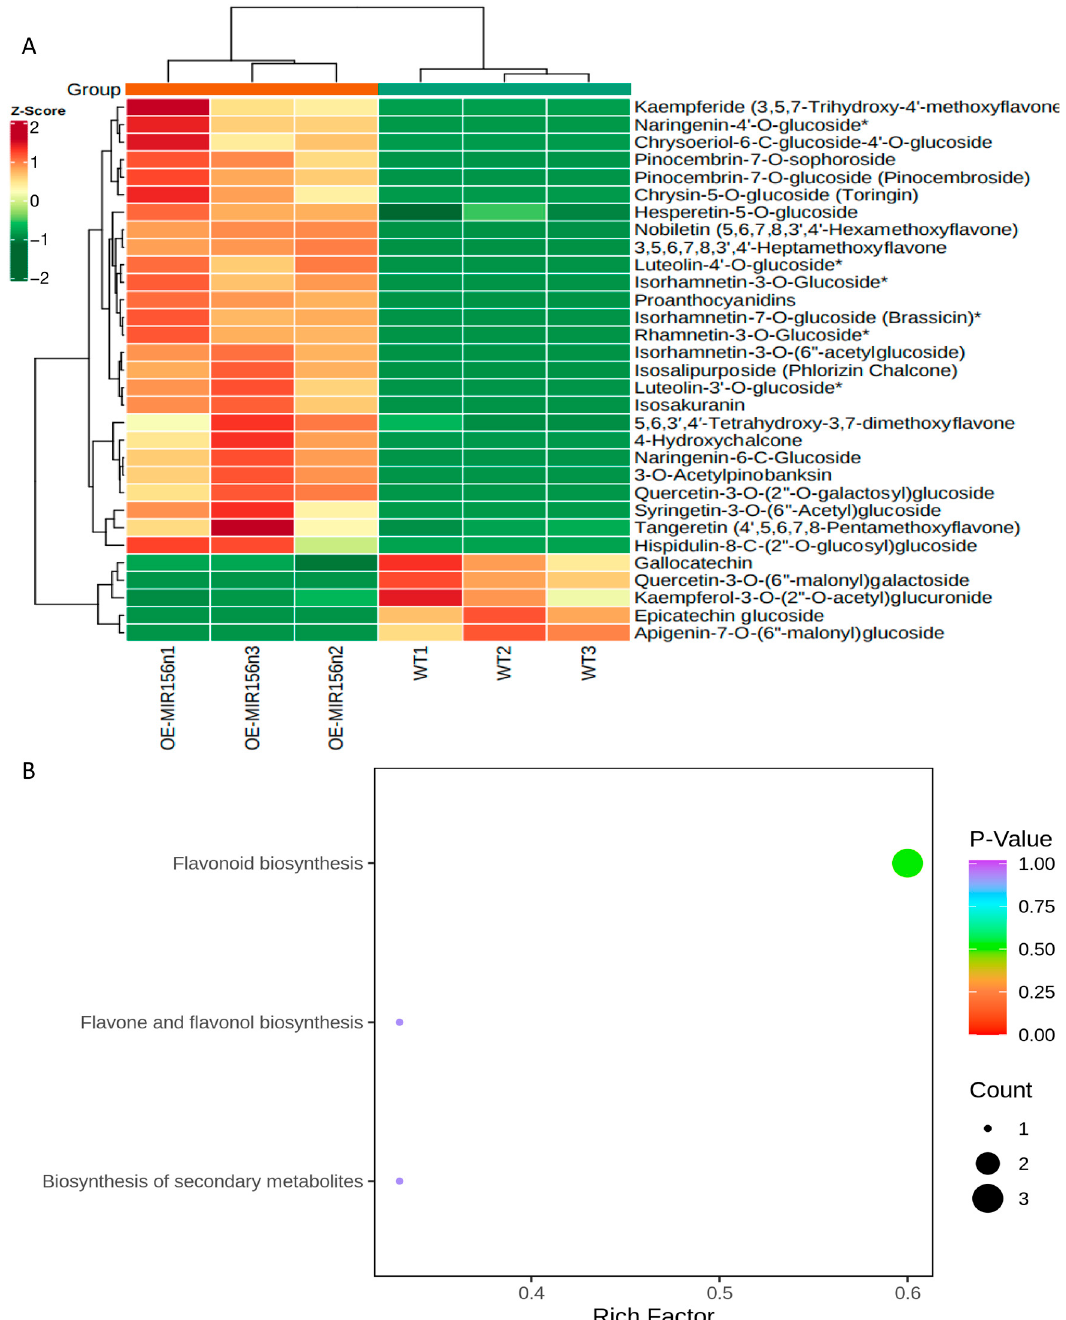
Figure 7. Differential flavonoid metabolite analysis in WT vs. OE- Mdmir156n : ( A ) Heat map of significantly differential flavonoid metabolites in WT vs. OE- Mdmir156n . Red and green color indicates the content of significant differential metabolites, respectively. Columns and rows represent samples and individual metabolites, respectively. The depth of color indicates the value of the correlation coefficient. The asterisk denotes the metabolite has isomerism. ( B ) Enrichment analysis of the KEGG pathway for differential metabolites in WT vs. OE- Mdmir156n . The color and size of the dots represents the p value and the amount of enriched differential metabolites, respectively. Rich factor means the ratio of the number of differential metabolites to the total number of metabolites enriched in a specific